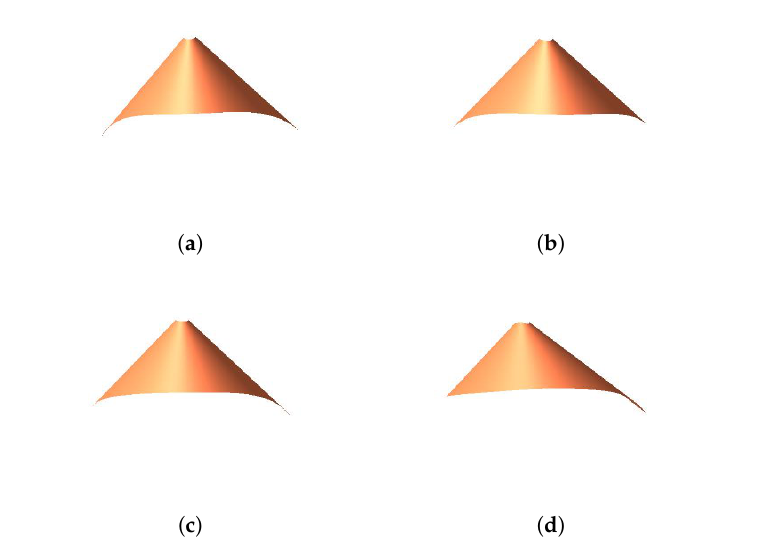
Figure 6. The effects of parameter α 3 on the 1 × 3 developable surface. ( a ) α 1 = π